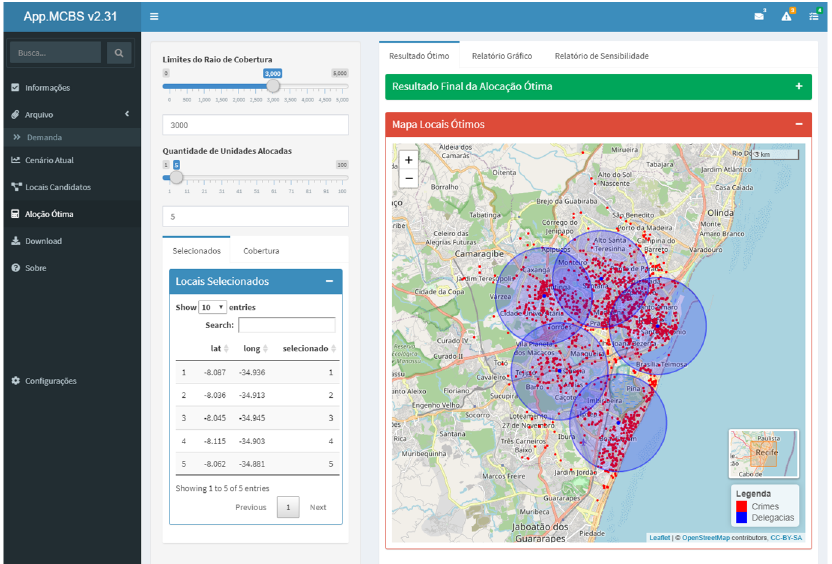
Figure 8. Optimal police facility allocation for 3.0 km coverage.